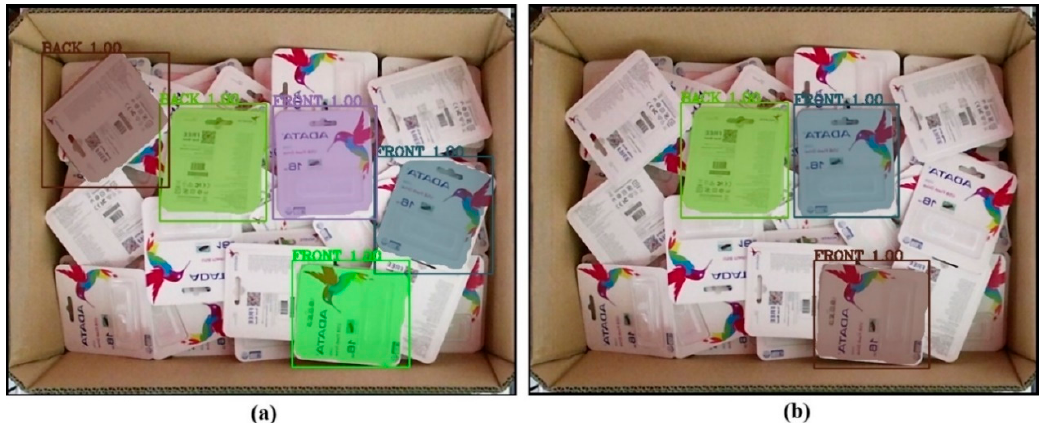
Figure 24. Result after passing through the filter at a fixed area threshold percentage criteria: ( a ) 90%, ( b ) 95%.